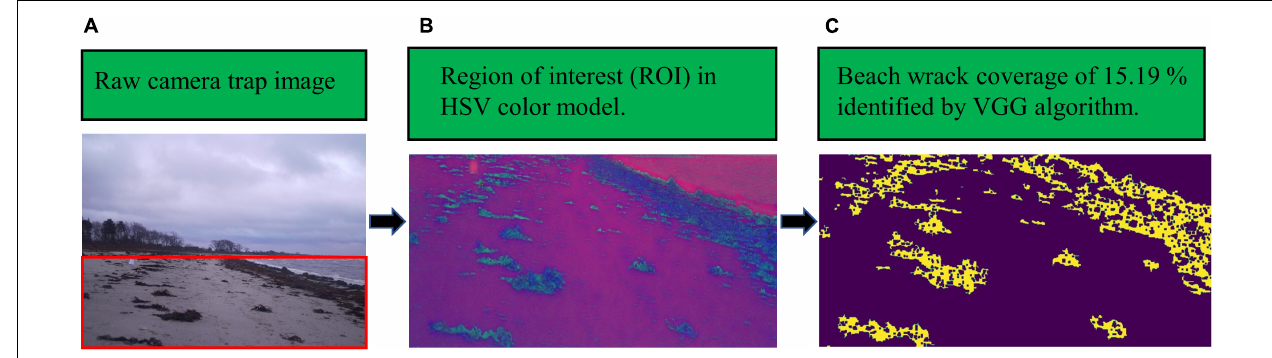
FIGURE 2 | An example of the VGG network identifying beach wrack from a camera trap image: panel (A) is the raw camera trap image in RGB color space, shot at 12:26, 08/12/2019, the red square shows the beach captured in the image (region of interest, ROI); panel (B) is the ROI after conversion to the HSV color model; panel (C) is the beach wrack identification result of the VGG network, highlighted in yellow and showing a coverage of 15.19%. TABLE 2 | The evaluation of VGG algorithm performance in identifying beach wrack obtained from the verification set (20% of images from each beach wrack distribution scene). Category of beach Scene of beach VGG network accuracy Example of image identification result scenario wrack distribution (mean ± SE, %) Raw image Manual recognition VGG